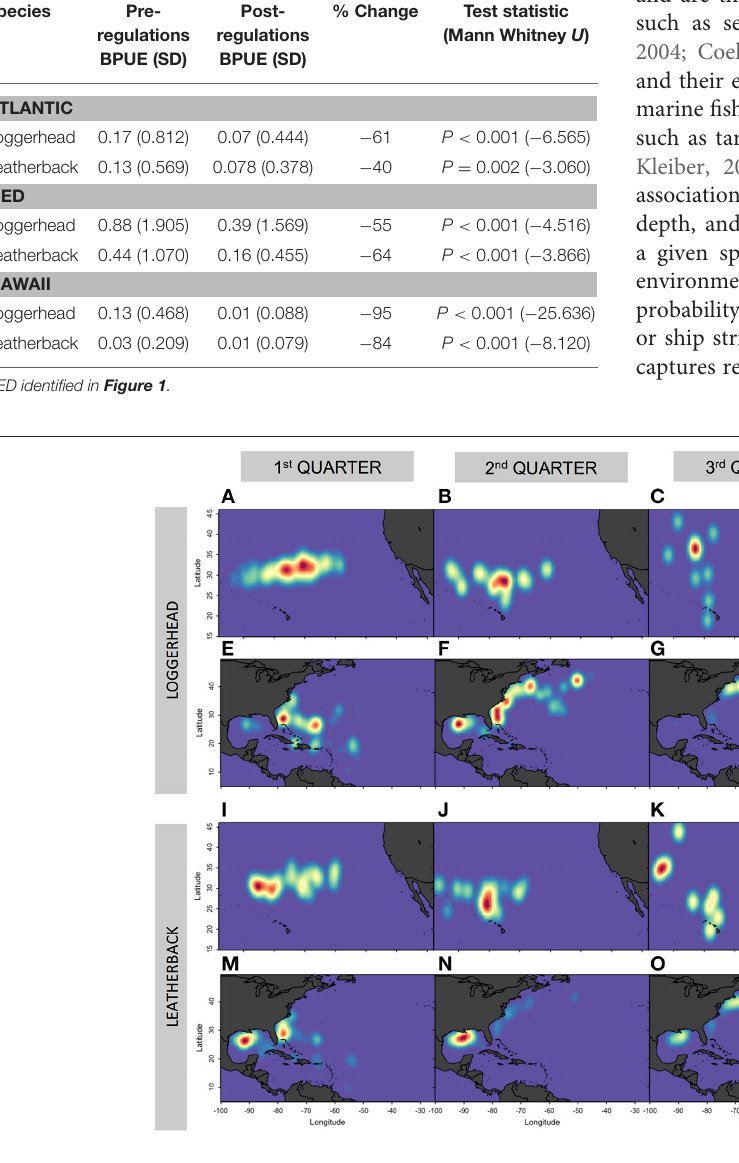
FIGURE 6 | Spatial kernel density plots of loggerhead ( top, upper figure ) and leatherback ( bottom, upper figure ) turtle captures by area and quarter from Atlantic observer data. Spatial kernel density plots of loggerhead ( top, lower figure ) and leatherback ( bottom, lower figure ) turtle captures by quarter from Hawaii observer data. Loggerhead turtle plots (A–D) are 1st through 4th quarter in Pacific and (E–H) are 1st through 4th quarter in the Atlantic. Leatherback turtle plots (I–L) are 1st through 4th quarter in in the Pacific and (M–P) are 1st through 4th quarter in the Atlantic.